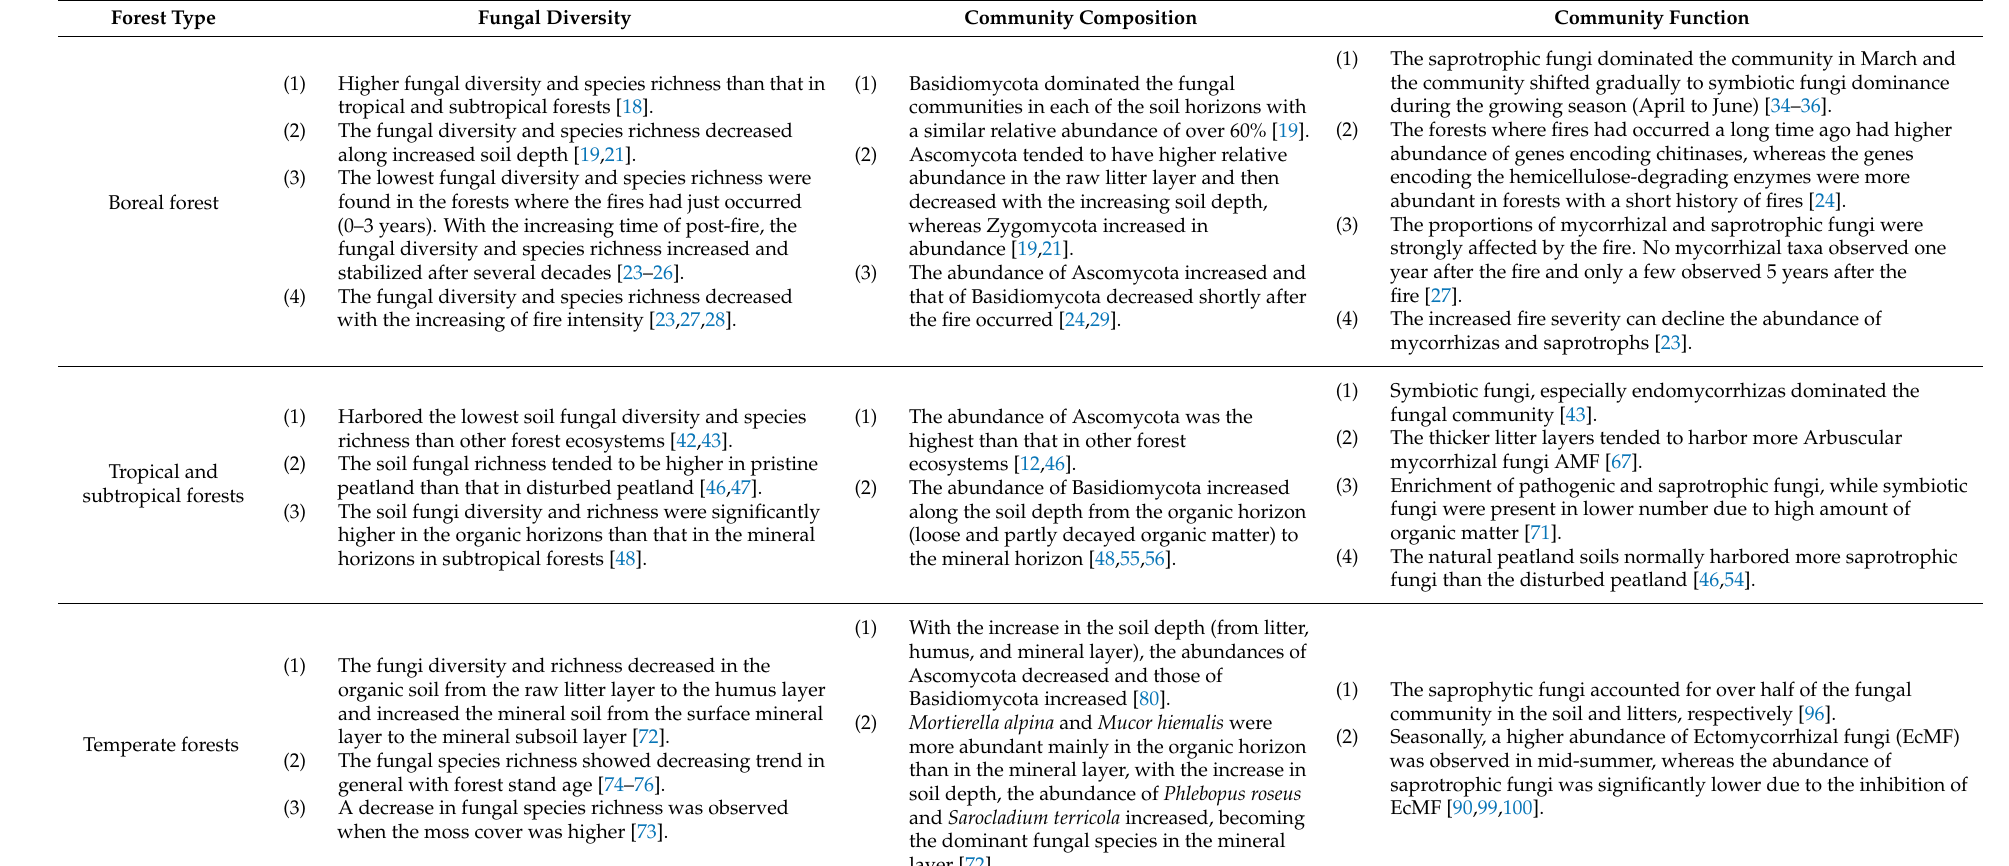
Table 1. Soil fungal diversity, community composition, and function in different forest